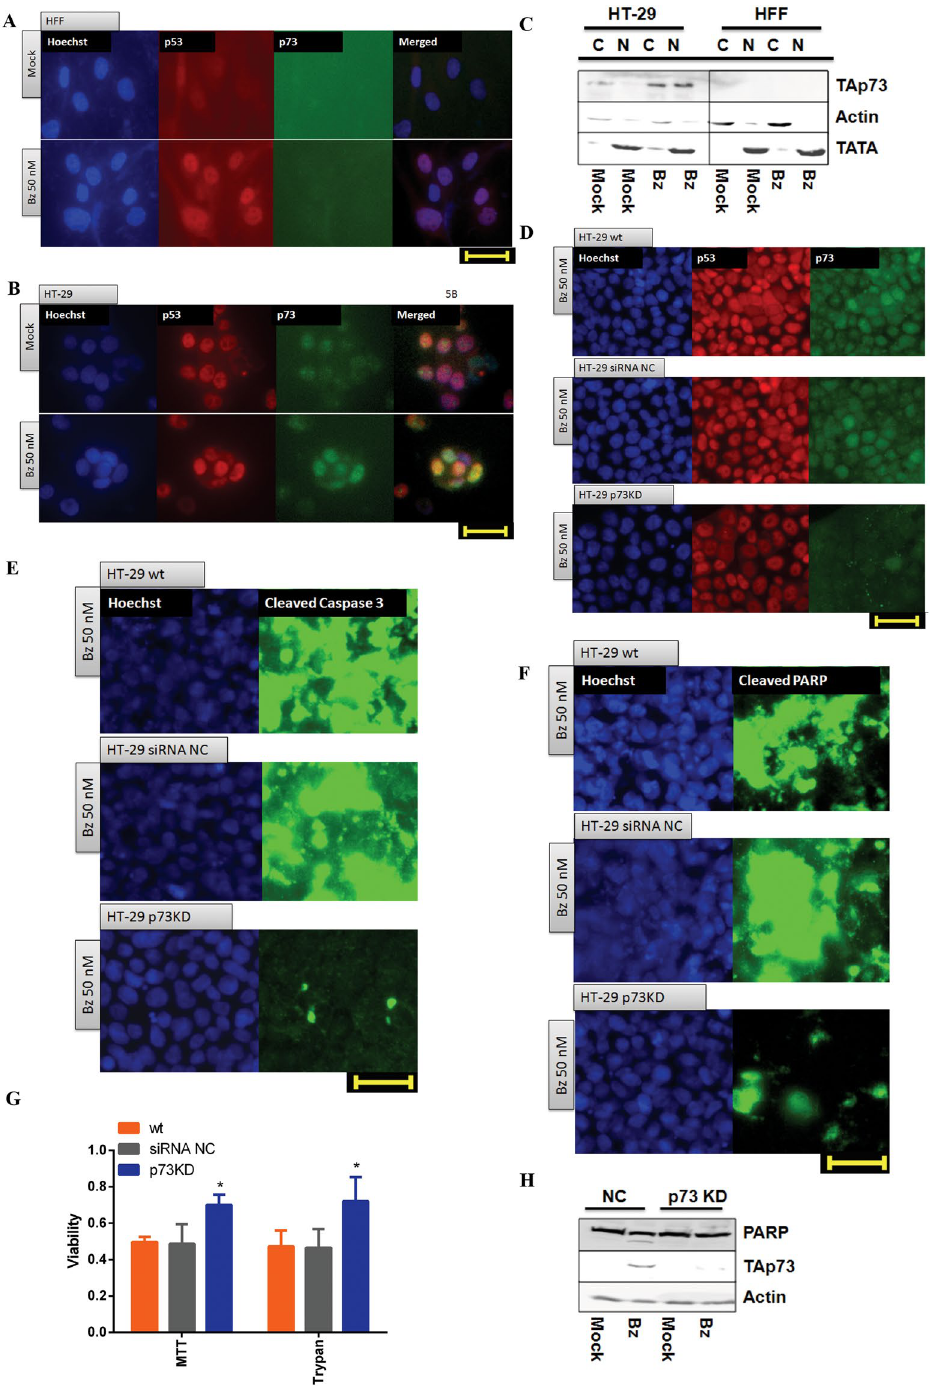
Figure 5. p73-deficient HT-29 cells are refractory to bortezomib. ( A ) 24 hrs treatment of bortezomib (50 nM) did not cause p73 nuclear accumulation in human fibroblast (HFF) detected by p53 (red) and p73 (green) antibodies in immunoncytochemistry. Scale bar: 40 µ m. DMSO 0.5% was used as mock. ( B ) Nuclear accumulation of p73 appeared upon bortezomib treatment (50 nM for 24 hrs) in HT-29 cells. Scale bar: 40 µ m. DMSO 0.5% was used as mock. ( C ) Bortezomib (50 nM) induced p73 nuclear accumulation in HT-29 cells after 24 hrs but not in HFF, using separated subcellular extracts. Final concentration of 0.5% DMSO was used as mock. ( D ) Comparison of p73 translocation to the nucleus upon bortezomib treatment (50 nM for 24 hrs) between HT-29, HT-29 transfected cells with non-targeting siRNA (HT-29 siRNA NC) as negative control, and HT-29 p73 knockdown cells (HT-29 p73KD). Scale bar: 40 µ m. ( E ) Reduced cleaved Caspase 3 in HT-29 p73KD in contrast to its parental cell line and HT-29 siRNA NC after 24 hrs treatment of bortezomib (50 nM) Scale bar: 40 µ m. ( F ) Reduction of cleaved PARP in HT-29 p73KD, compared to HT-29 and HT-29 siRNA NC cells upon 24 hrs of bortezomib treatment (50 nM). Scale bar: 40 µ m. ( G ) Evaluation of cell viability in HT-29